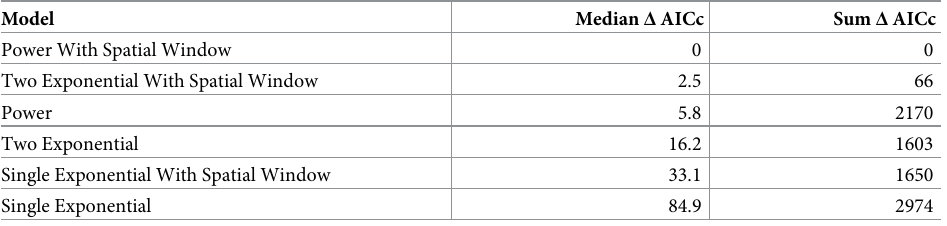
Table 1. Model fit comparison. Median and sum differences in Akaike’s Corrected Information Criteria (AICc) between each model and the best fitting model (power with spatial window) are reported, sorted by median difference.